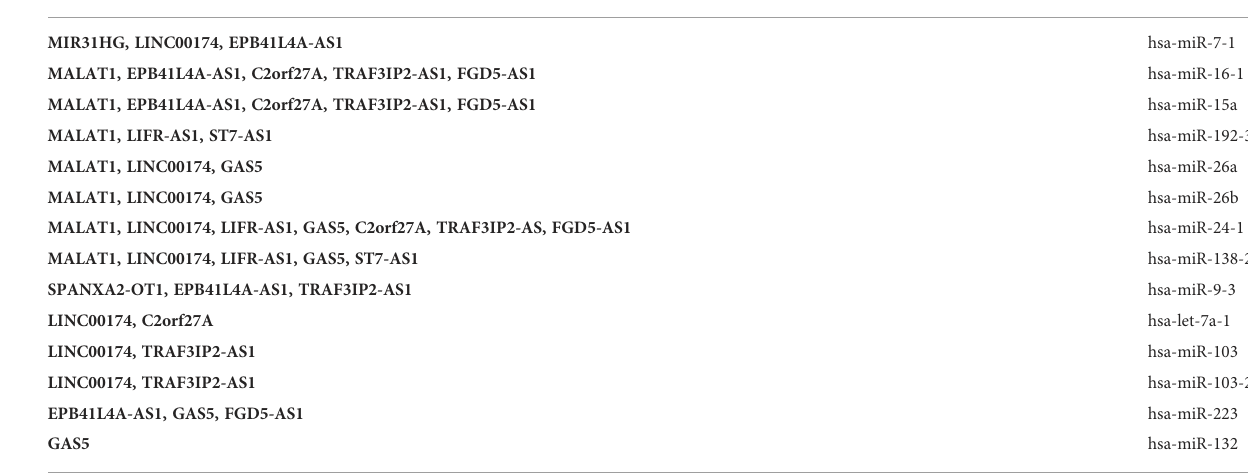
TABLE 4 The MiRcode database revealed interactions between 12 DElncRNAs and 14 DEmiRNAs. lncRNA